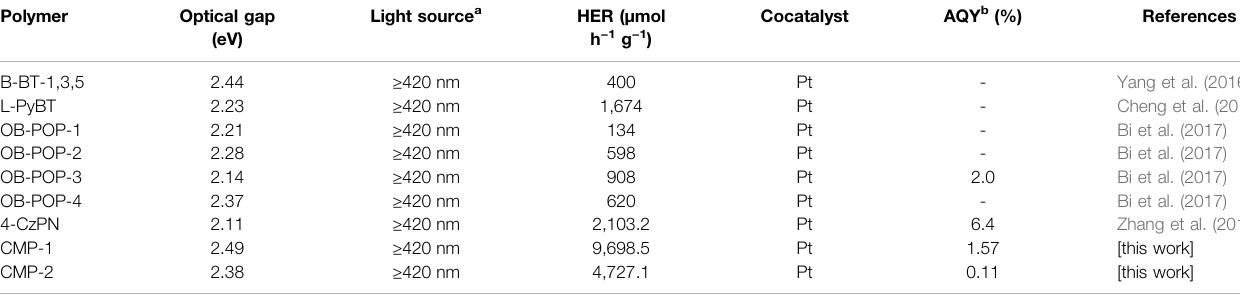
TABLE 1 | The photocatalytic H 2 evolution rate of some CMPs. Polymer Optical gap